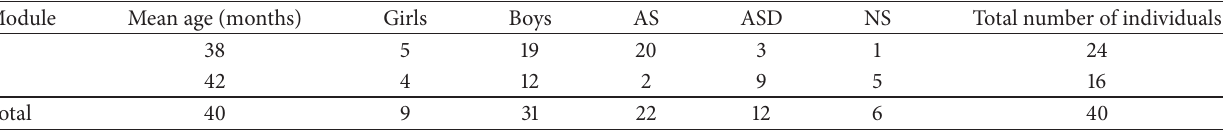
Table 1: Participants by module, age, gender, and clinical diagnosis. Module 1 = preverbal, module 2 = phrase speech.